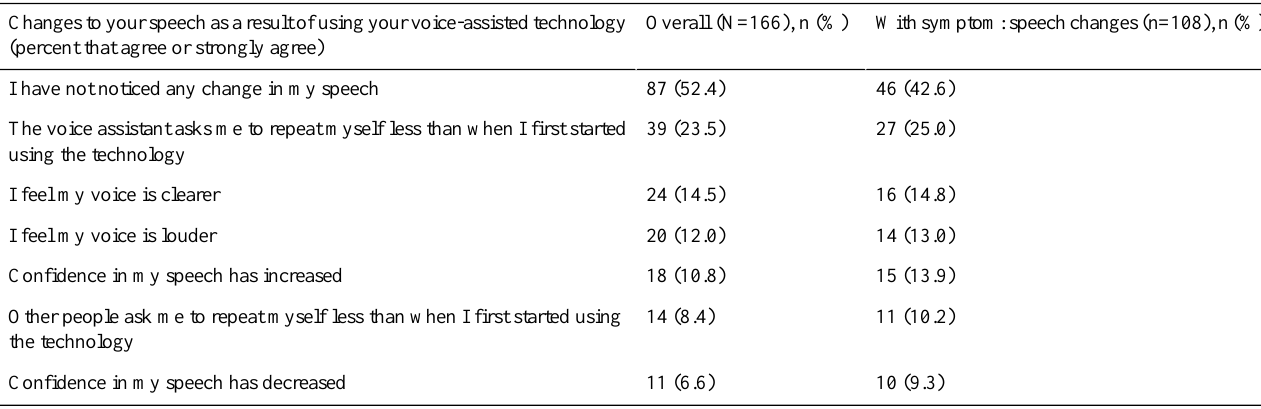
Table 3. Changes to speech as a result of using voice-assisted technology by the overall population and by respondents who experience speech changes as a symptom of Parkinson